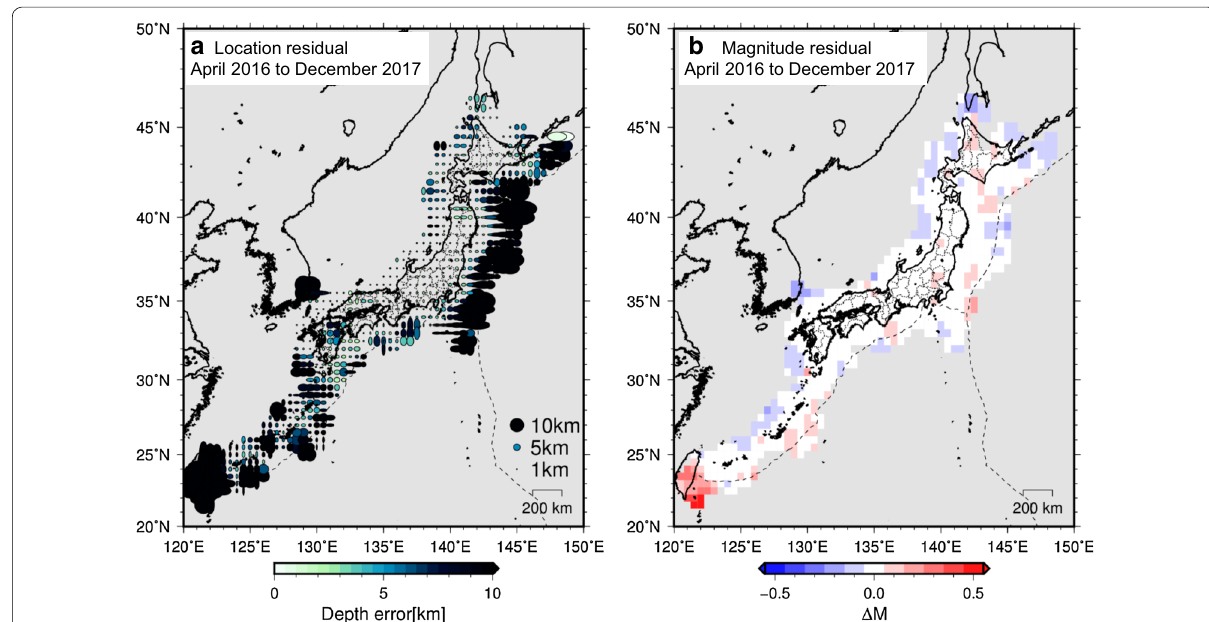
Fig. 6 Distribution of a location and b magnitude residuals between fully reviewed hypocenters in the JMA unified catalog (flag K, depth range 0–50 km) and their associated automatically processed hypocenters (before visual inspection) from April 2016 to December 2017